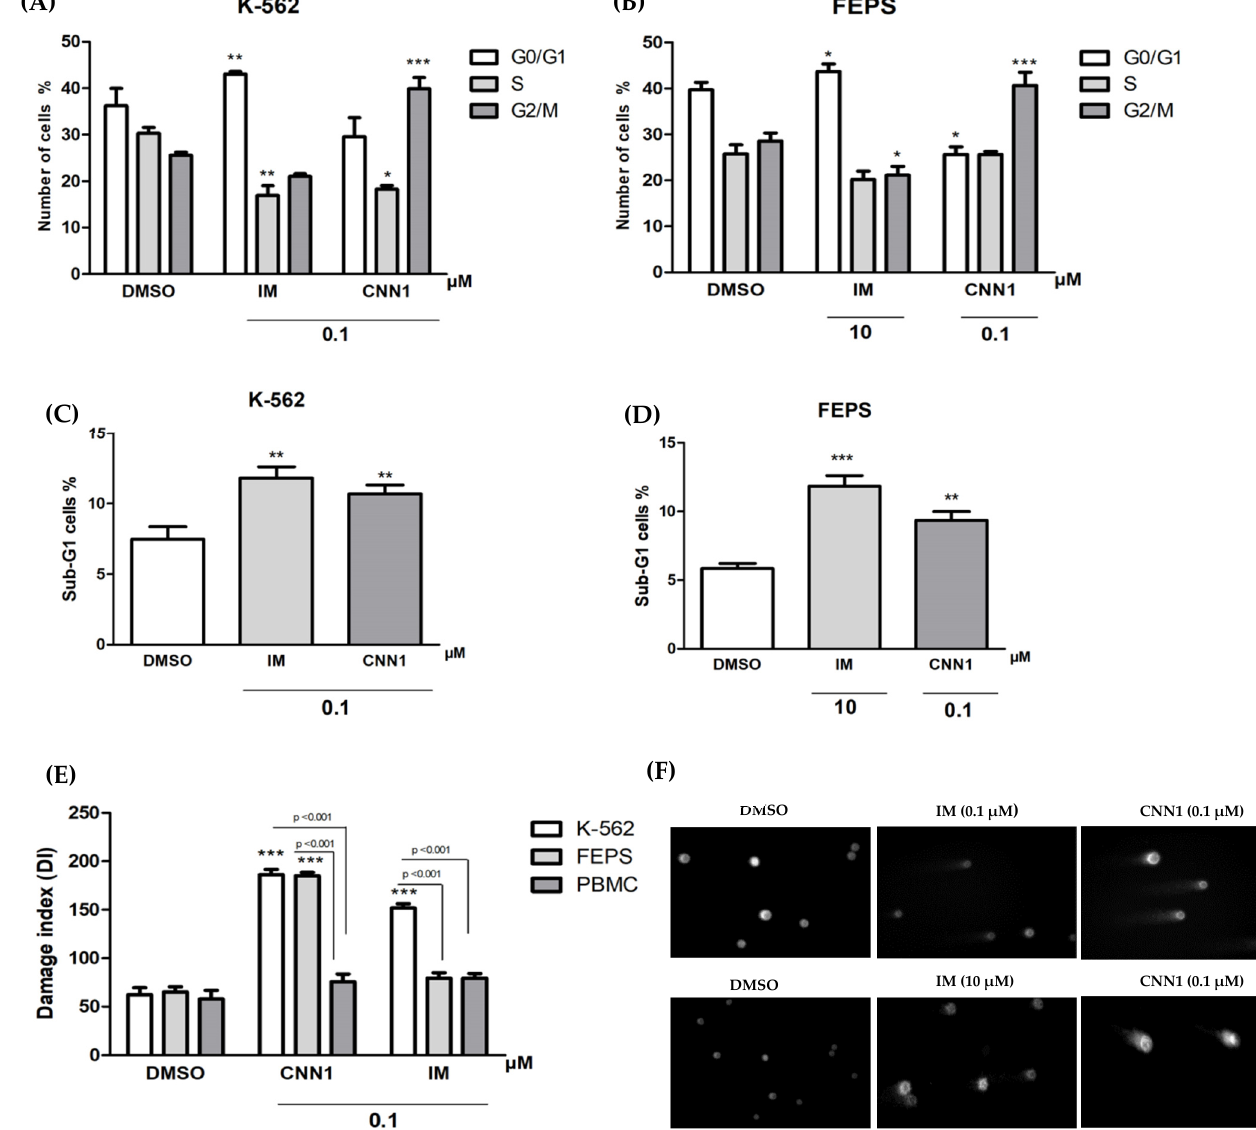
Figure 2. Induction of DNA fragmentation, cell cycle arrest and genotoxic effect after treatment with CNN1 in leukemia cells and PBMC by alkaline comet assay. IM was positive control: ( A ) Effect of CNN1 in cell cycle in K-562 cell line; ( B ) activity of CNN1 in cell cycle in FEPS cell line; ( C ) representation of effect of CNN1at number of cells in sub-G1 of K-562; ( D ) number of cells in sub-G1 phase of K-562 and FEPS cell lines after CNN1 exposure; ( E ) alkaline comet assay in leukemia cell lines and PBMC; ( F ) distribution of DNA migrations from negative control (DMSO) and treated groups, using light microscope. The number of cells in G0/G1, S and G2/M phase was calculated using FlowJo ™ software. Treated samples were compared to DMSO. The bars represent the mean ± standard error of the mean of three independent experiments. Significant differences compared to control (DMSO) * p < 0.05, ** p < 0.01, *** p < 0.001 by ANOVA followed by Bonferroni